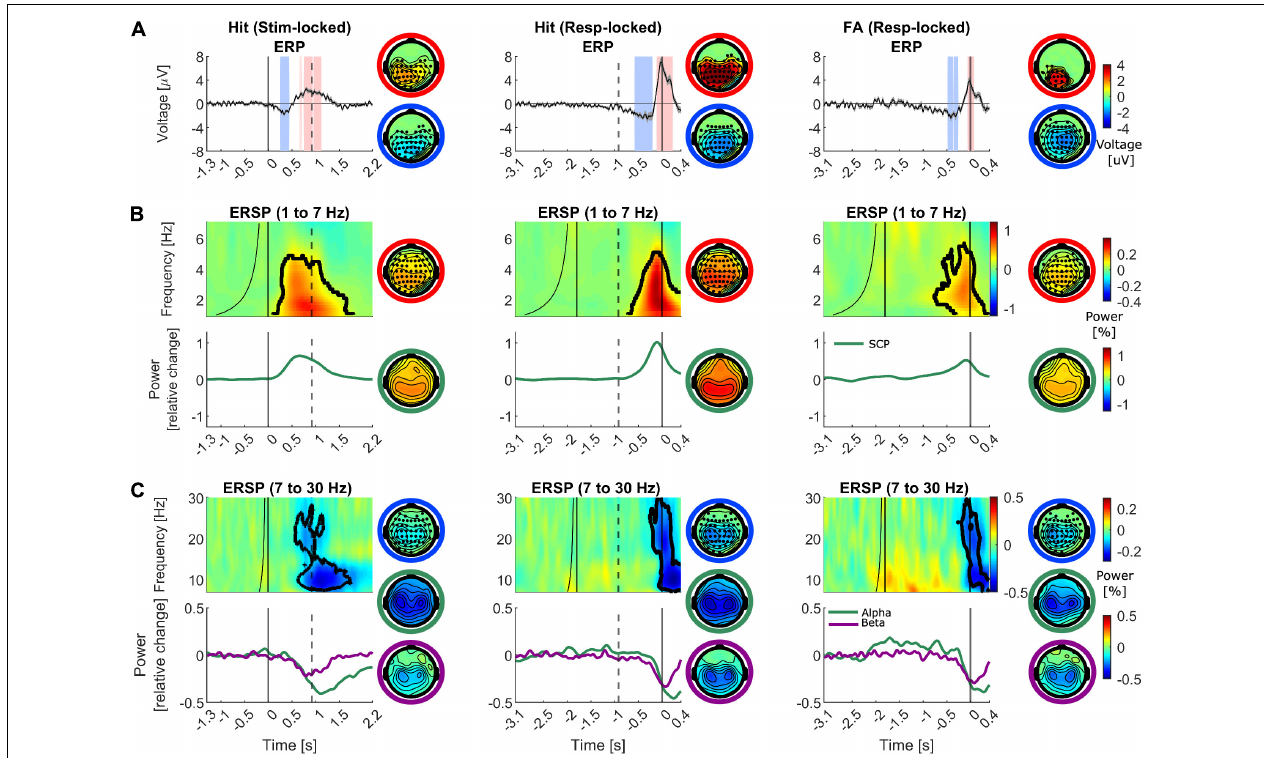
FIGURE 3 | Group-averaged ERP, ERSP and spectral profiles for different frequency bands for hits and FAs. Time is denoted on the x -axis in seconds. The left column depicts the hits aligned to the stimulus onset, the middle column illustrates the data corresponding to hits aligned to the response execution and the right column exhibits FAs (aligned to the response time). The dashed vertical line marks the median reaction time in the left column and the median stimulus onset in the middle column. The scalp topographies with marked electrodes as filled circles represent the significant cluster distributions (negative difference: blue outer circle, positive difference: red outer circle). The rest of the scalp topography maps represent the spatial spread of the half width at half prominence of the illustrated peak or trough in the left part of the panel (also color coded with the outer circle). (A) Baseline corrected ERPs (left: –1.3 to –1.1 s, middle and right: –3.1 to –2.9 s). The shaded areas around the ERPs denote the standard error of the mean. The shaded intervals in light red and blue mark the significant interval with positive and negative differences with respect to baseline. (B,C) ERSPs for each trial group are plotted for a representative channel. Frequency (in Hz) is shown on the y -axis. The plotted values are in units of the power change relative to the baseline power. The baseline time range at each frequency is the interval between the minimum latency illustrated in the plot and the black curve. The time range between the curve and the straight line to its right marks the marginal boundary between the baseline and the activation intervals accounting for the temporal smearing caused by the wavelets’ temporal width. The significant cluster for the plotted electrode is marked by the black contour. (B) Top row: ERSPs are plotted for the frequency range of 1–7 Hz for electrode “Pz” as a representative of the time-frequency spectral pattern. Bottom row: The Spectral power traces plotted for SCP range. (C) Top row: average ERSPs are plotted for the frequency range of 7–30 Hz for electrodes “C3” and “C4” as a representative of the time-frequency spectral pattern. Bottom row: The Spectral power traces plotted separately for alpha and beta frequency